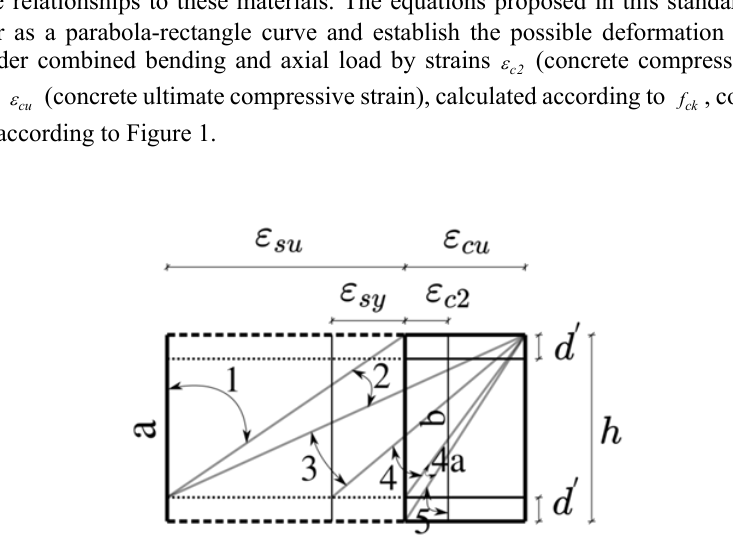
Figure 1. NBR 6118 [5] deformation domains for reinforced concrete sections under combined bending and axial